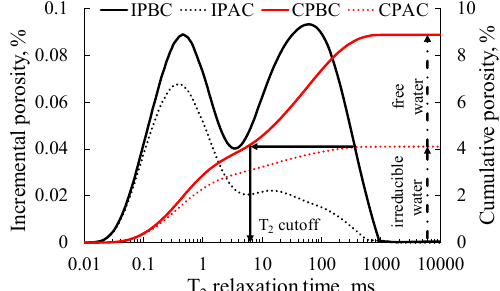
Figure 13. Specimen 11# shows a method to determine T 2 cutoff in 9100 r·min − 1 rotation speed. IPBC — incremental porosity before centrifugation; IPAC — incremental porosity after centrifugation; CPBC — cumulative porosity before centrifugation; CPAC — cumulative porosity after centrifugation.